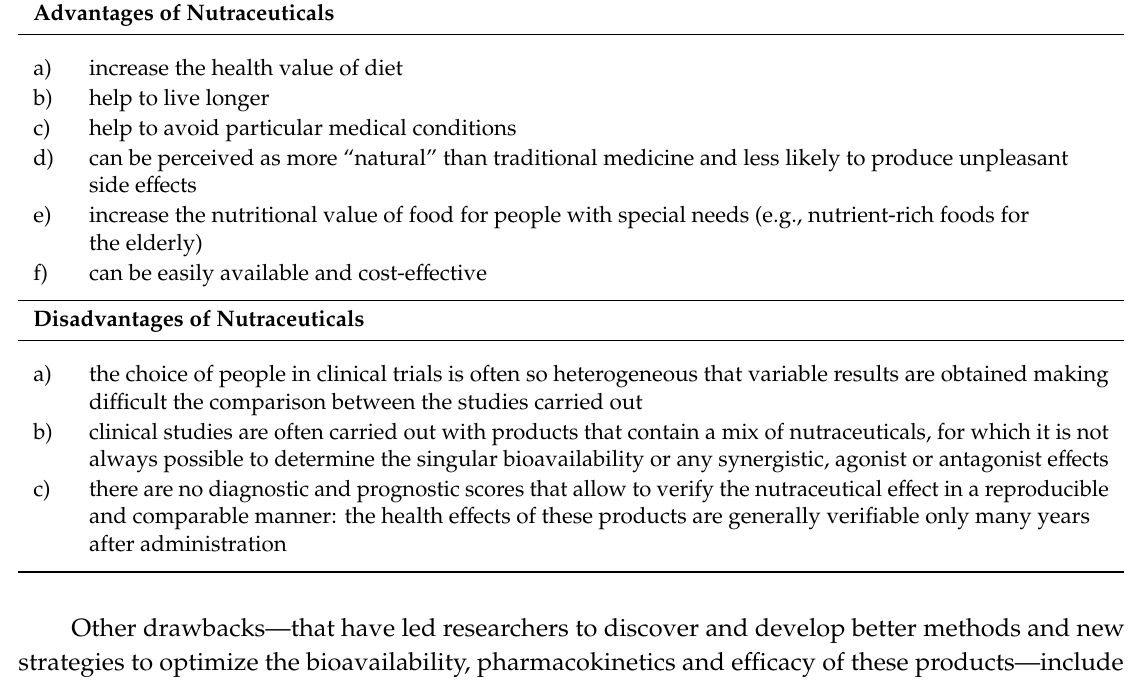
Table 1. Nutraceuticals: potential health benefits and